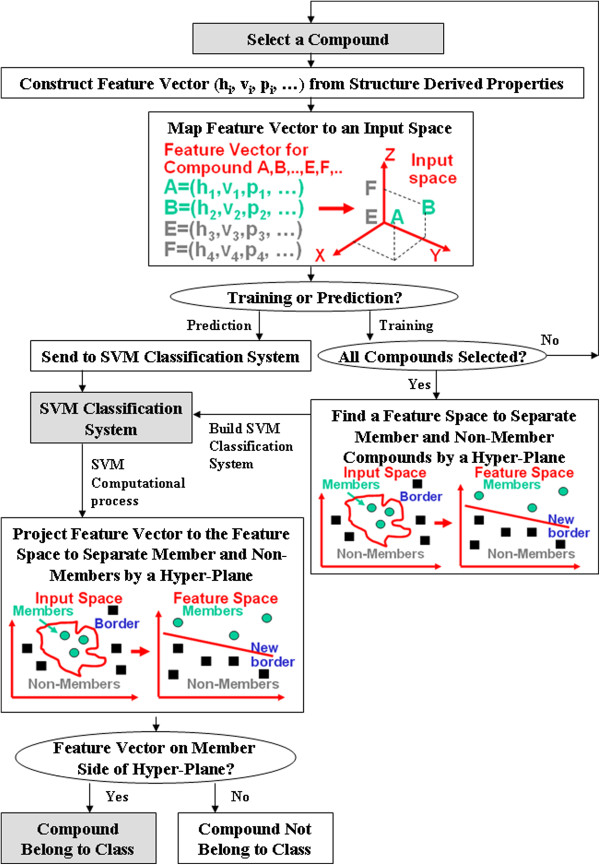
The process of training and using a SVM VS model for screening compounds. Schematic diagram is illustrating the process of the training a prediction model and using it for predicting active compounds of a compound class from their structurally-derived properties (molecular descriptors) by using support vector machines. A, B, E, F and (hj, pj, vj,…) represents such structural and physicochemical properties as hydrophobicity, volume, polarizability, etc.